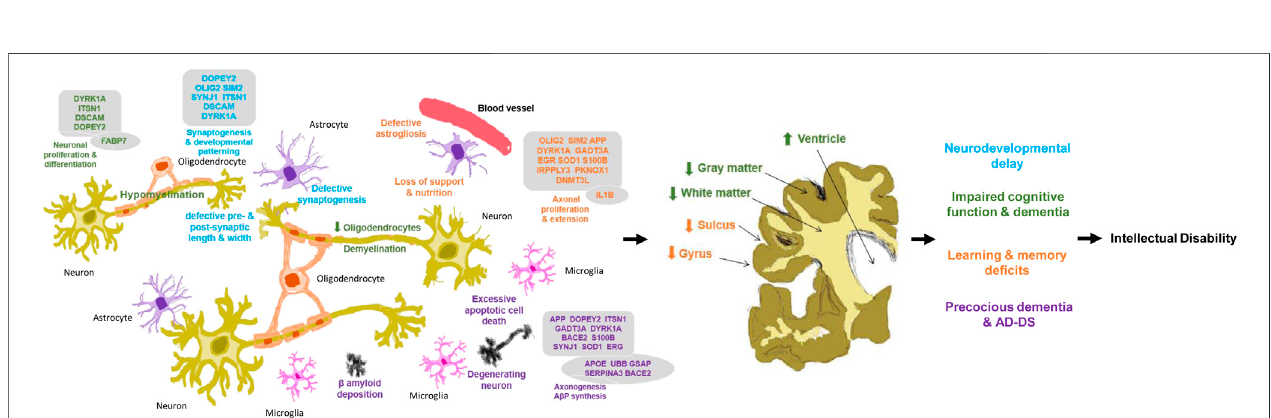
FIGURE 6 | Neuropathology in Down syndrome brain in human. Relationship of brain development genes, molecular, cellular, anatomical changes and clinical manifestationsforthedevelopmentofintellectualdisabilityinDownsyndrome.Genesinboxesaschromosome21genes;genesincircleasnon-chromosome21genes. Changes in blue lead to defective synaptogenesis and pre- and post-synaptic length and width, thereafter neurodevelopmental delay; green lead to reduced oligodendrocytes andhypo-andde-myelination,thereafterimpairedcognitivefunctionand dementia;orange leadtodefectiveastrogilosisandlossofsupportand nutritionthereafterlearningandmemoryde fi cits;andpurpleleadtodegeneratingneuron,excessiveapoptosisand β -amyloiddeposition,thereafterprecociousdementia & AD-DS. Arrows ↑ / ↓ as direction of the gene expression and